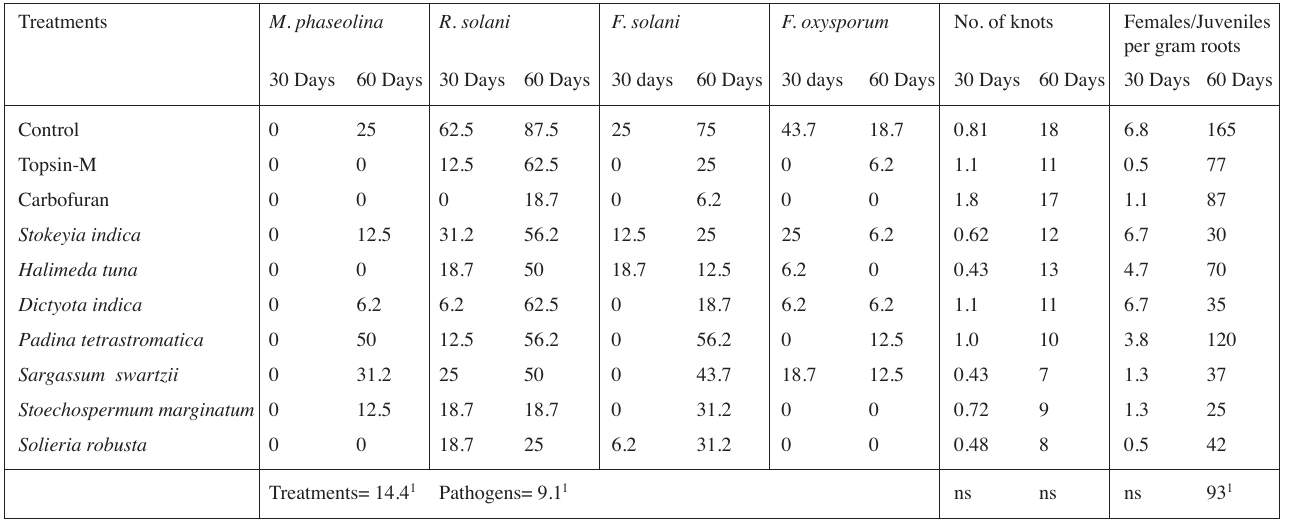
Tab. 3: Effect of seaweeds on the infection of root rotting fungi Macrophomina phaseolina, Rhizoctonia solani, Fusarium solani F. oxysporum and Meloidogyne javanica on soybean roots in field experiment.